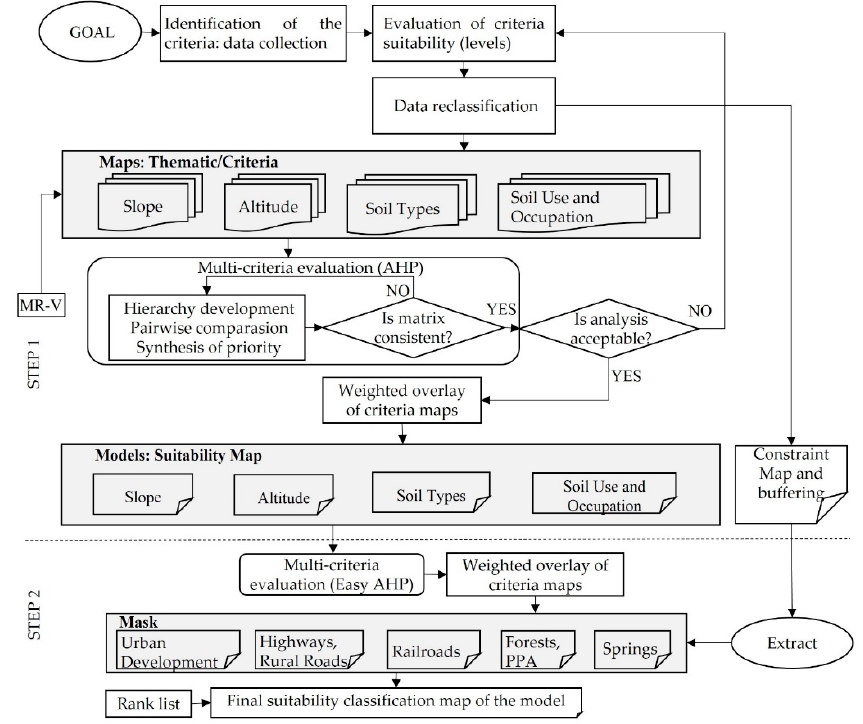
Figure 2. Workflow for the methodological procedure applied to determine site suitability for ground-excavated ponds to be used for fish farming. Adapted from Bagdanavi č i ū t ė et al. [18].